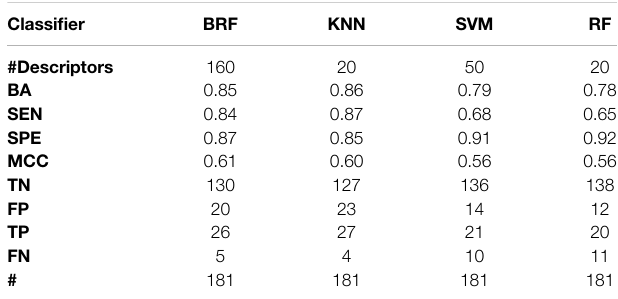
TABLE 5 | Performance of the best models developed on the HSE vs INA partitioning scheme on the TeS. For each model, the following statistics are reported: Balanced Accuracy (BA), Sensitivity (SEN), Speci fi city (SPE), Matthews CorrelationCoef fi cient(MCC),numberofTrueNegatives(TN),FalsePositives(FP), True Positives (TP) and False Negatives (FNs).